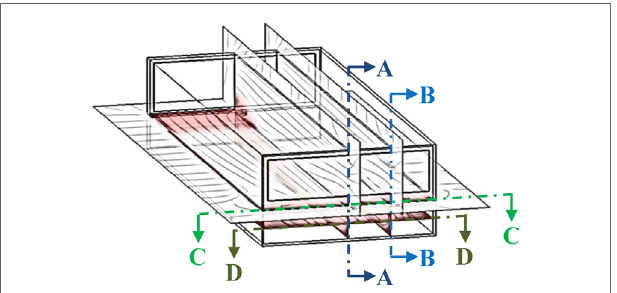
FIgURe 8 | Definition of animation barn + pit cut-plot locations: vertical longitudinal section through center line (A–A); vertical longitudinal section at quarter point (B–B); horizontal section 152 mm above manure pit cover (c–c); and horizontal section at manure pit mid-height